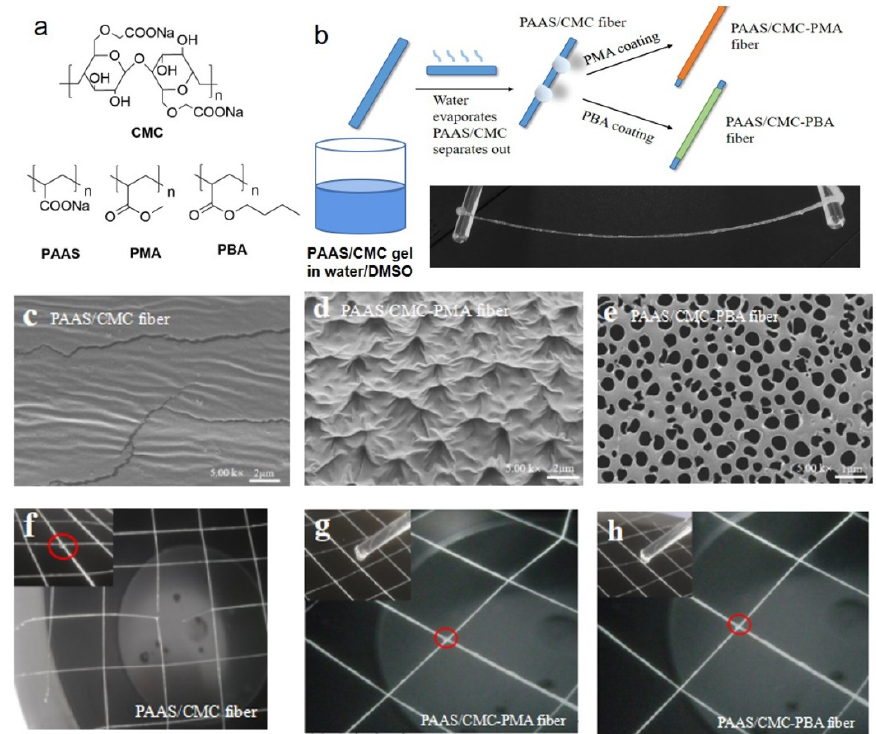
Figure 12. ( a ) Chemical structure of carboxymethyl cellulose (CMC), sodium polyacrylate (PAAS), PMA and polybutyl acrylate (PBA). ( b ) Preparation of conductive hydrogel fibers by gel spinning. Inserted image shows the photo picture of as-prepared PAAS/CMC fiber. SEM images of the surface of ( c ) PAAS/CMC fiber, ( d ) PAAS/CMC-PMA fiber and ( e ) PAAS/CMC-PBA fiber. The water resistance test of hydrogel fibers: ( f ) PAAS/CMC fiber web is quickly dissolved by liquid water, water droplets would not damage the hydrophobic PAAS/CMC-PMA fiber ( g ) and PAAS/CMC-PBA fiber ( h ). Red circles represent thorn-like structure indicating cratering effects after encountering liquid water. Adapted from Ref. [114]. Note that PAAS in this Figure corresponds to our PA sodium salt.